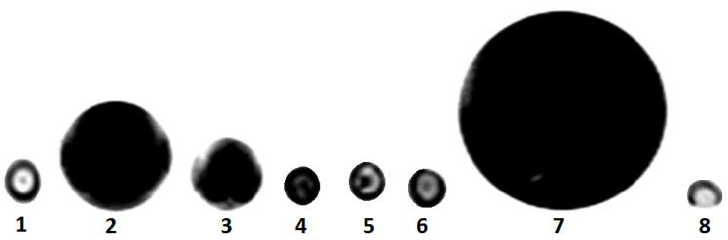
Figure 4. The T2* weighted MR imaging of in vitro samples. Group 1 contained 15% agarose gel only. In groups 2–6, 1 µL/mL of lipofectamine and 15% agarose gel were used for transfection of DPSCs and then 180, 90, 70, 50, and 30 µg/mL of iron oxide were applied for cell labeling, respec- tively. Group 7 was non-coated iron oxide nanoparticles and group 8 consisted of just H 2 O.